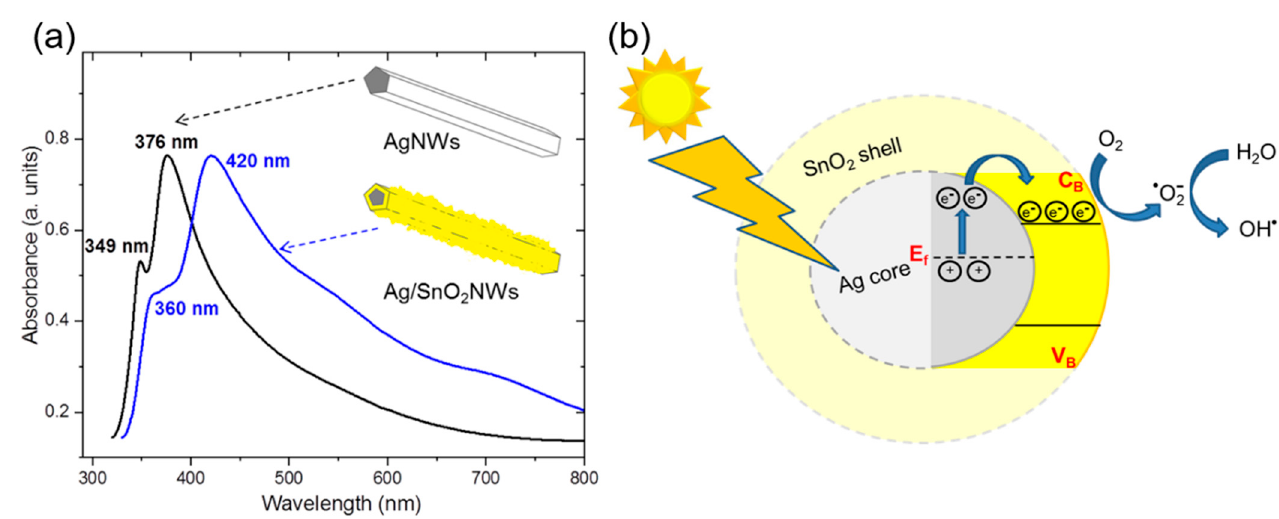
Figure 2. ( a ) The absorbance spectra of AgNWs and the core/shell Ag/SnO 2 NWs. ( b ) Schematic illustration of the photocatalytic mechanism of Ag/SnO 2 NWs under visible light